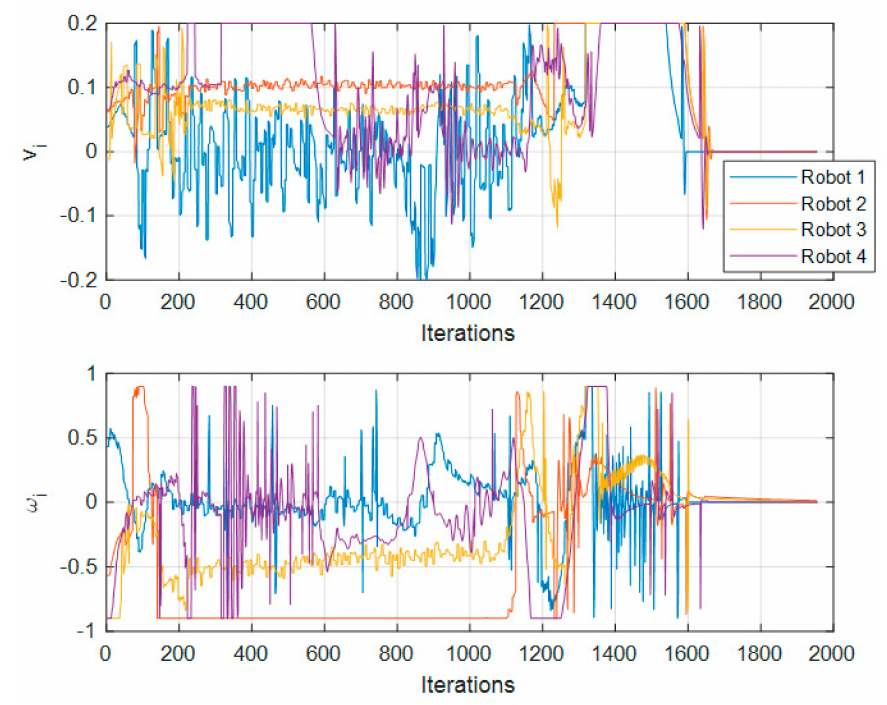
Figure 9. Input values for velocities along iterations in the 4-robot